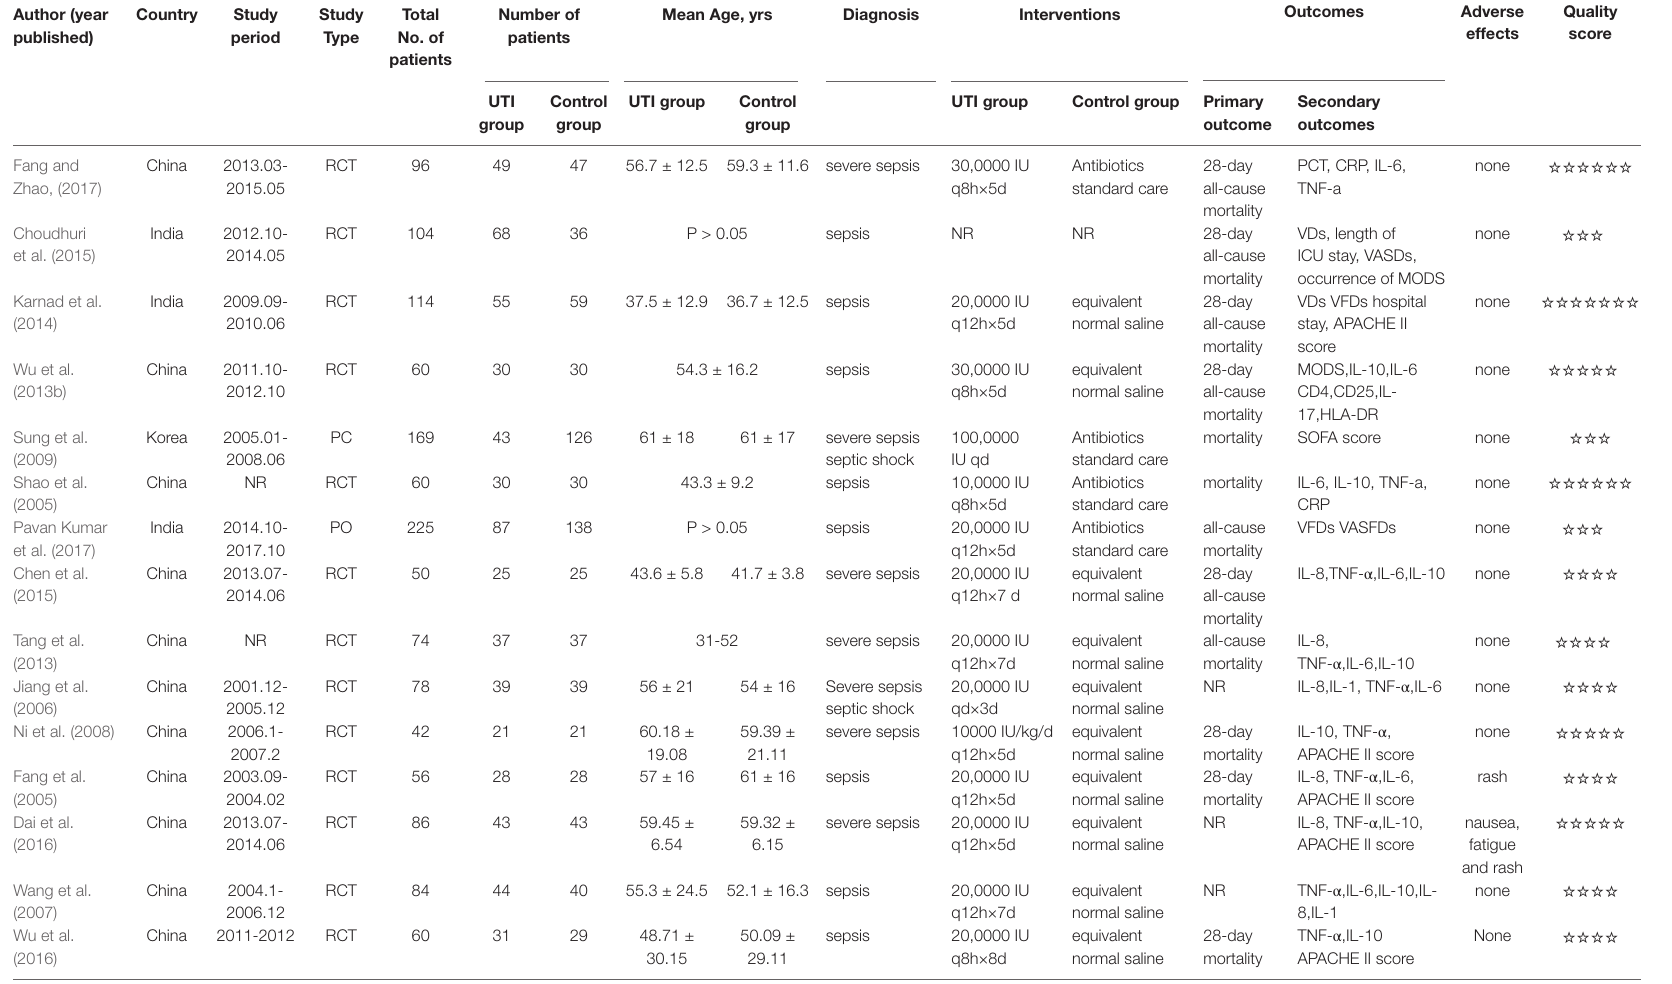
TABLe 2 | The characteristics of the included